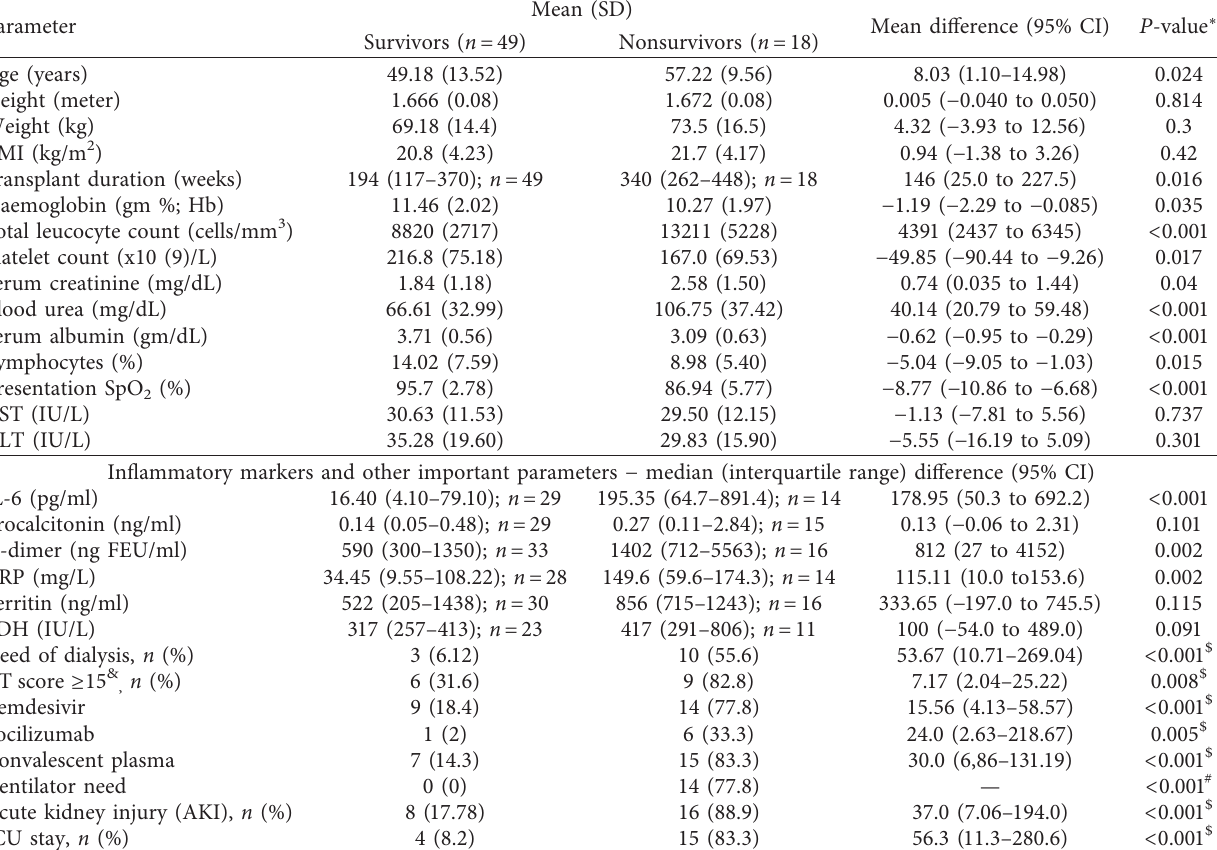
Table 4: Association between mortality and investigations of kidney transplant recipients with